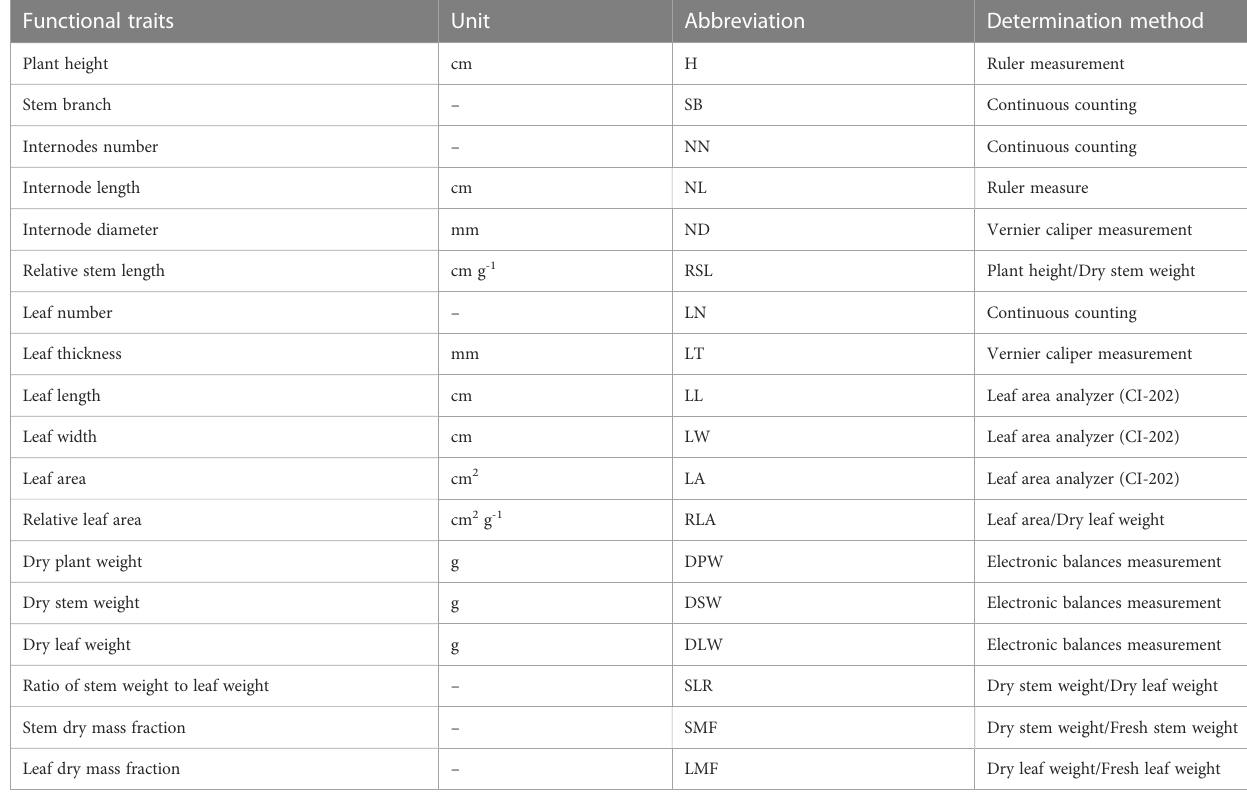
TABLE 1 Plant traits and their units, abbreviations, and determination methods. Functional